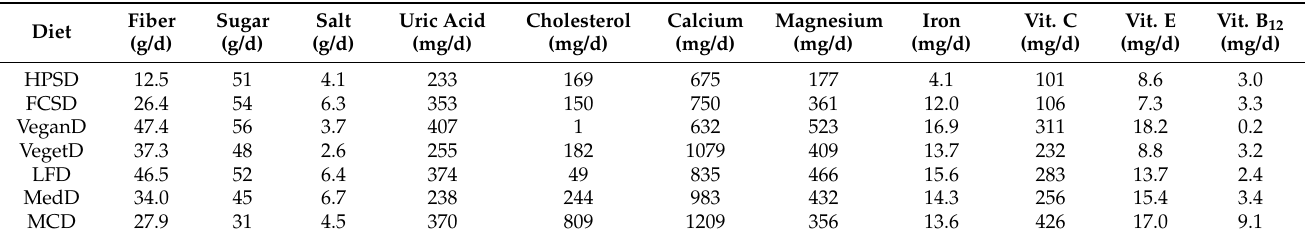
Table 3. Micronutrient composition of the model diets, based on 2000 kcal per